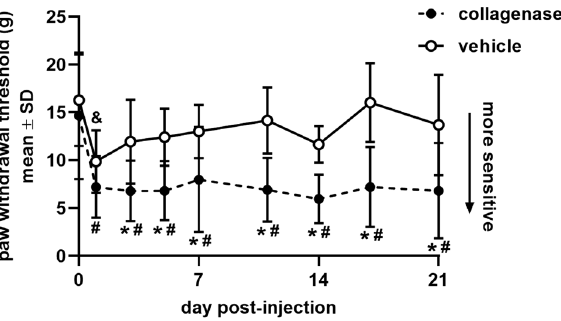
Figure 1. Paw withdrawal threshold (PWT) for 21 days after intra-articular injection of collagenase or vehicle. PWTs quantifying mechanically evoked pain-like behavior exhibit a decrease (corresponding to greater sensitivity) after collagenase injection (12 rats) at all days (#p < 0.001) compared to baseline (day 0). Intra- articular injection of vehicle (6 rats) produces a decrease in PWT from baseline (&p = 0.009) at day 1 that resolves by day 3. Starting on day 3, intra-articular collagenase induces sensitivity that is significantly lower (*p ≤ 0.036) than vehicle for all days of testing. All p-values are calculated using a repeated-measures ANOVA and post-hoc Tukey HSD tests; data are expressed as mean ± standard deviation (SD) for each group.